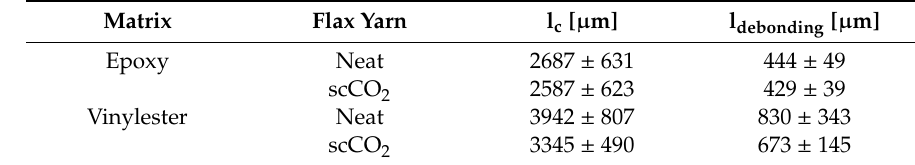
Table 4. Critical fragment length and debonding length values for the different single yarn composites.